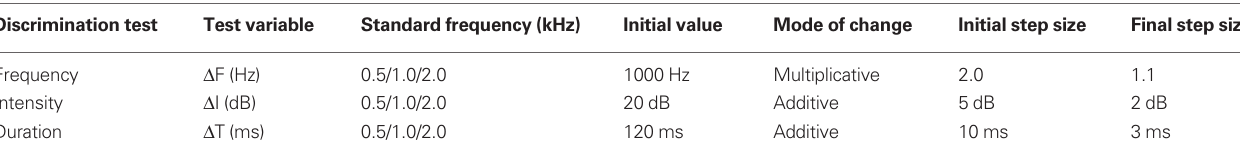
Table 1 | Test parameter overview.